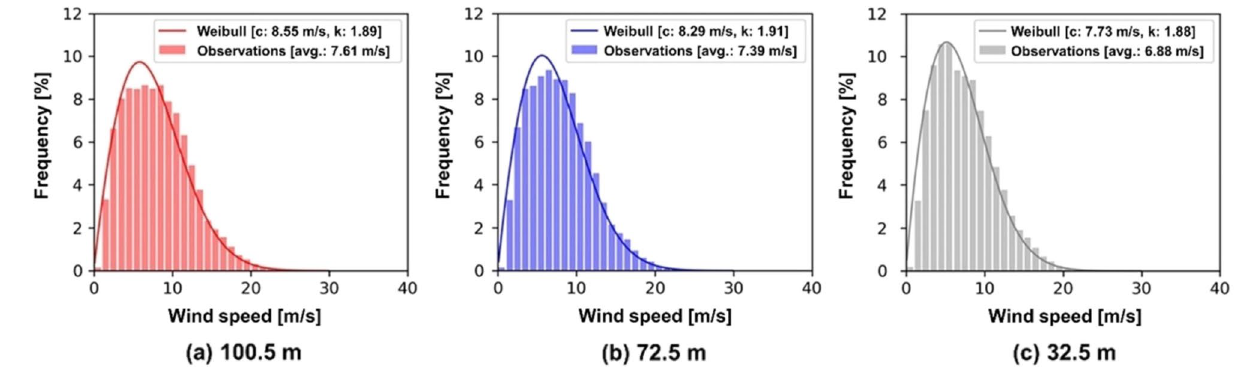
Figure 3. Weibull wind speed